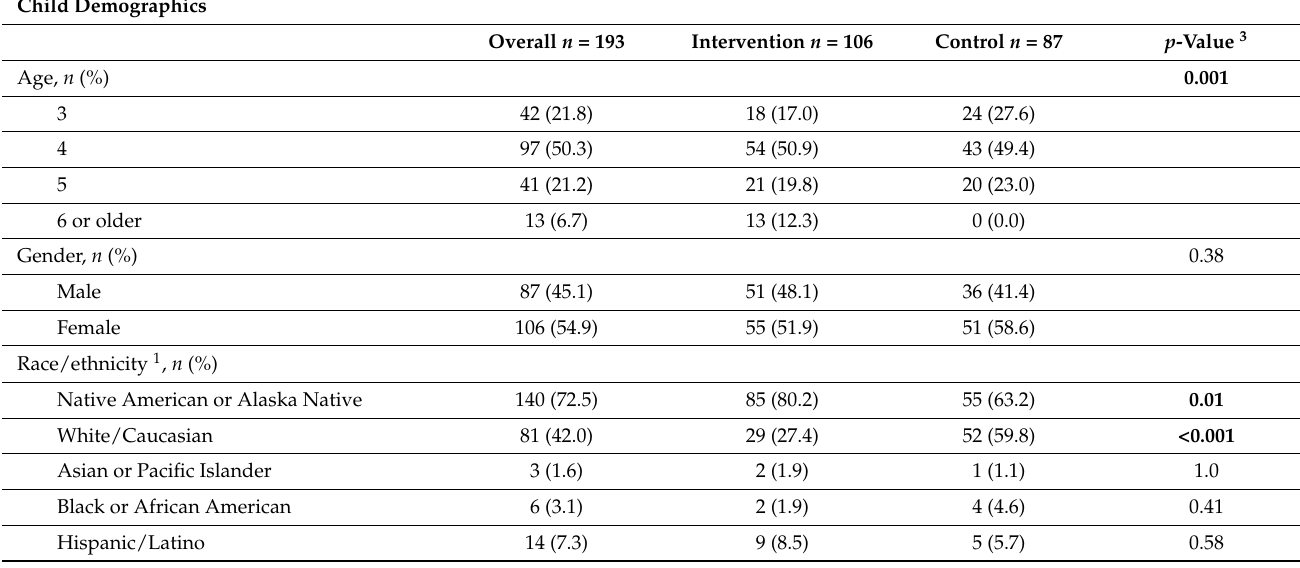
Table 1. Baseline characteristics for children and adults participating in the FRESH